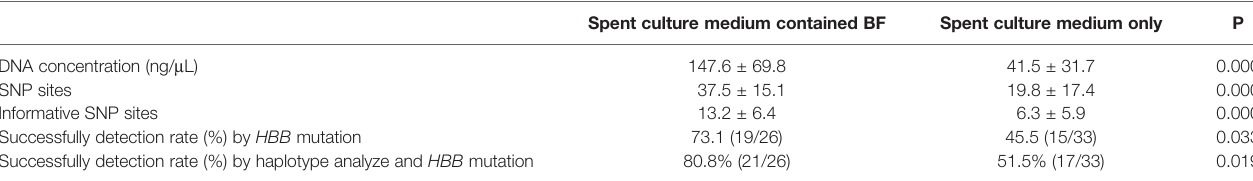
TABLE 1 | Samples from spent culture medium evaluated by